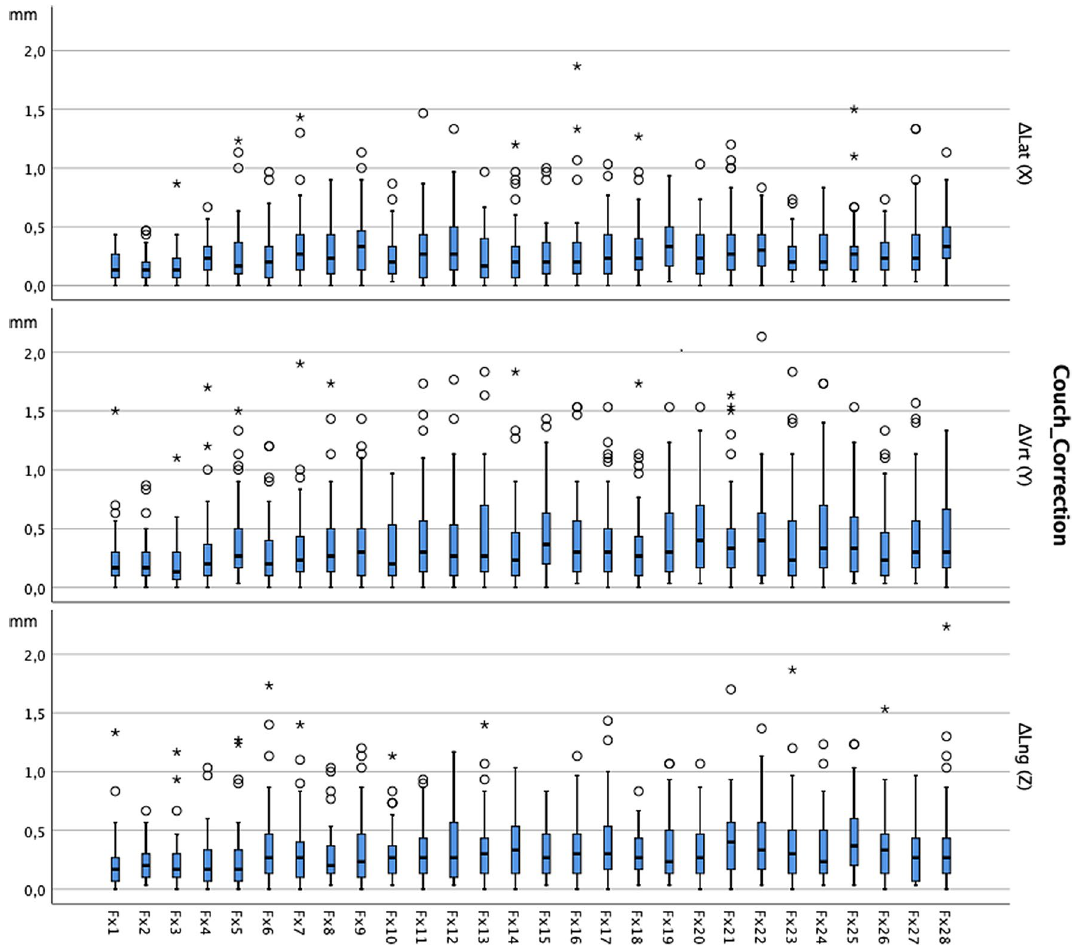
Figure 2. Deviation of marker-based position from CBCT-based position in the course of the treatment with 28 fractions. Median values (in mm) of all patients (n = 45) and 95% confidence interval (whiskers) treated with non-hypofractionated